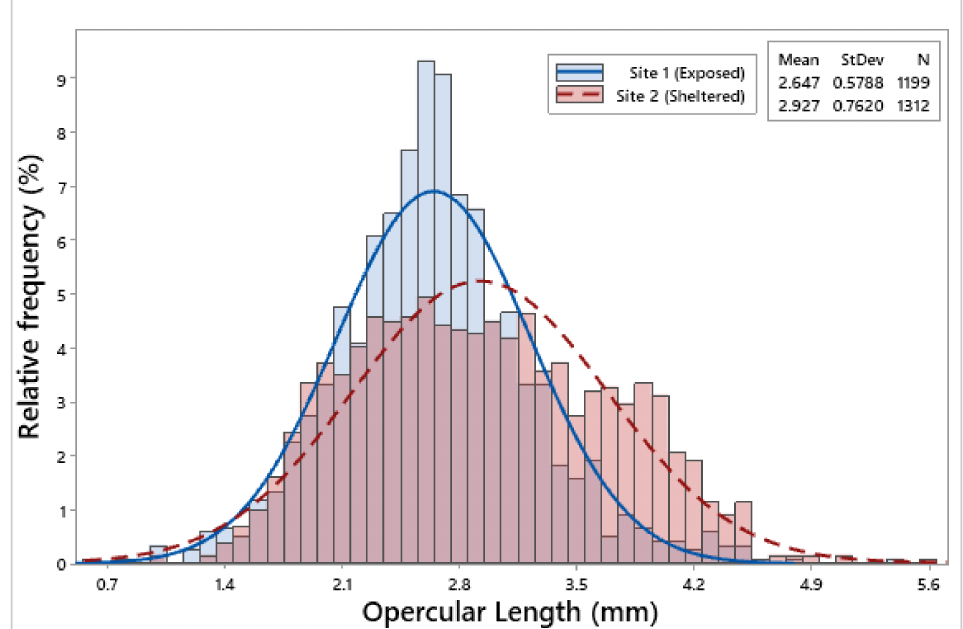
Figure 7. Total opercular length–frequency distribution of C. stellatus populations with overlaid fitted normal distribution at both sampling